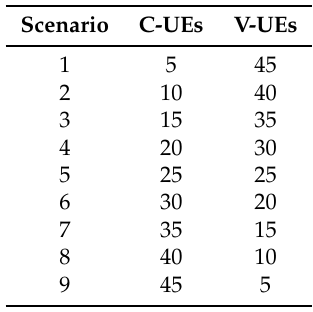
Table 2. Definition of